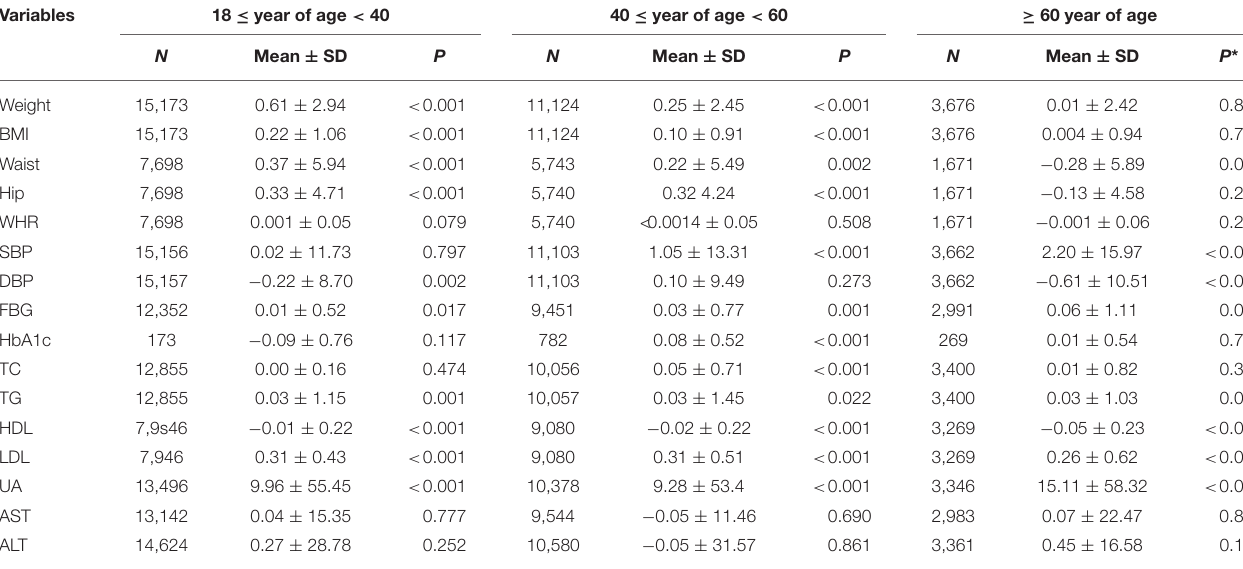
TABLE 4 | Paired cardiometabolic markers differences between 2020 and 2019 in different age groups (year in 2020).